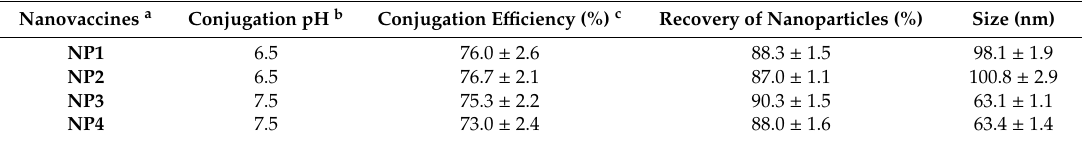
Table 1. Optimized conjugation conditions, e ffi ciency, and size of the nanovaccine formulations. Nanovaccines a